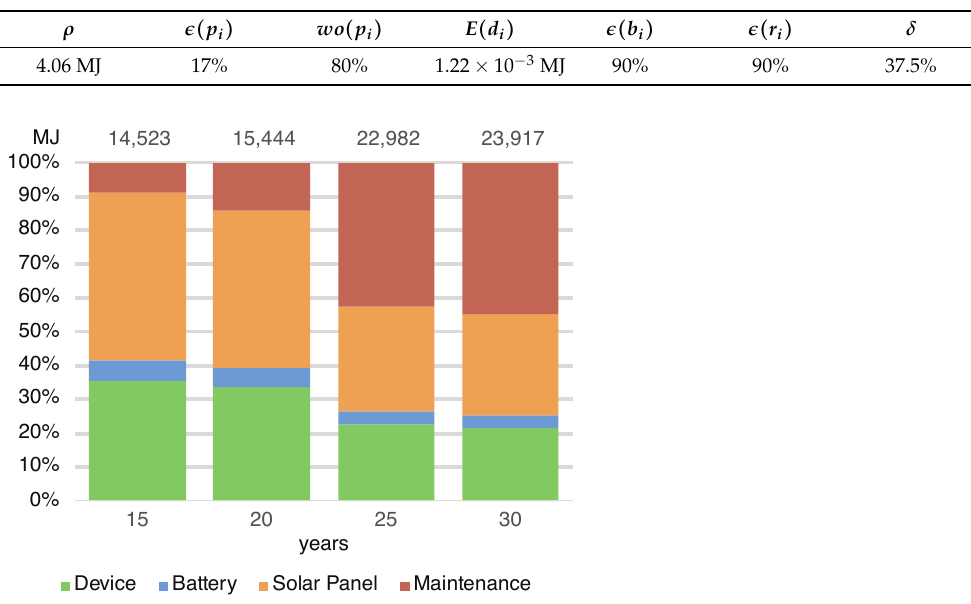
Table 5. Parameters needed to size solar panel and battery where ρ is the solar radiation [42], (cid:101) ( p i ) is the solar panel efficiency [64], wo ( p i ) is the efficiency of the solar panel in the 20th year [19], E ( d i ) is the device energy requirement, (cid:101) ( b i ) is the battery efficiency [20], (cid:101) ( r i ) is the efficiency of the output regulator [57] and δ is the percentage of hours of light [65].